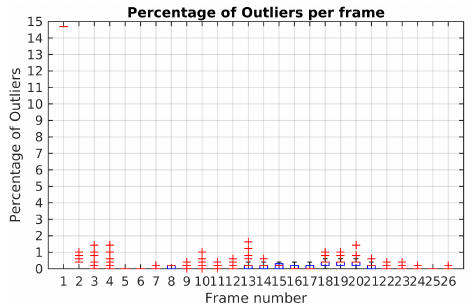
Figure 11. Outliers percentage in Monte-Carlo experiment for Scene 3 using